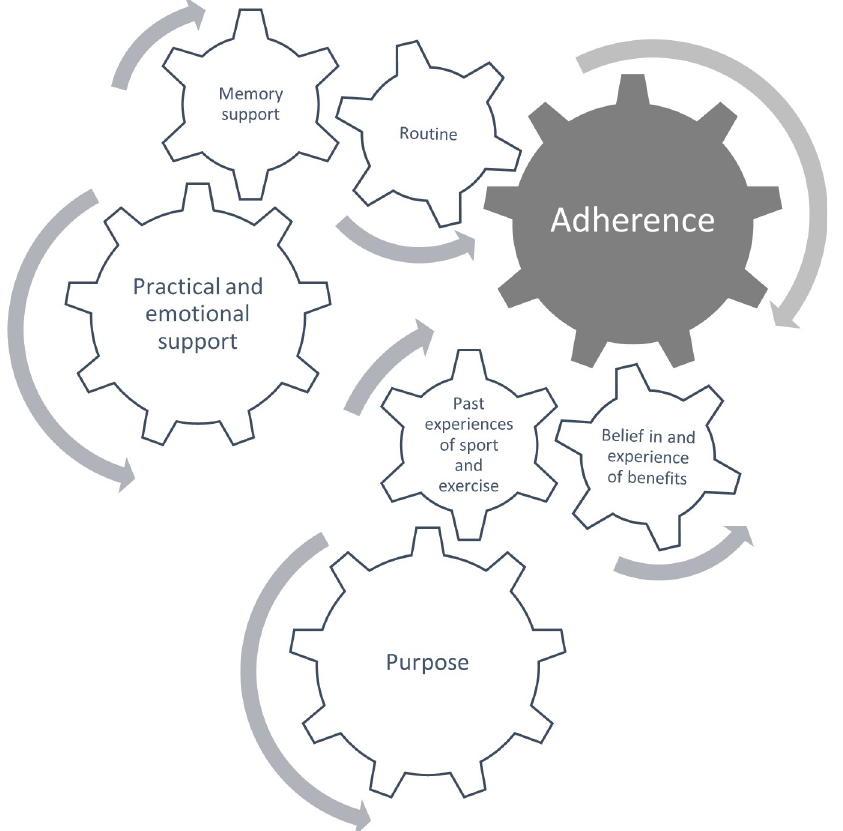
Fig 1. Illustration of interactions between